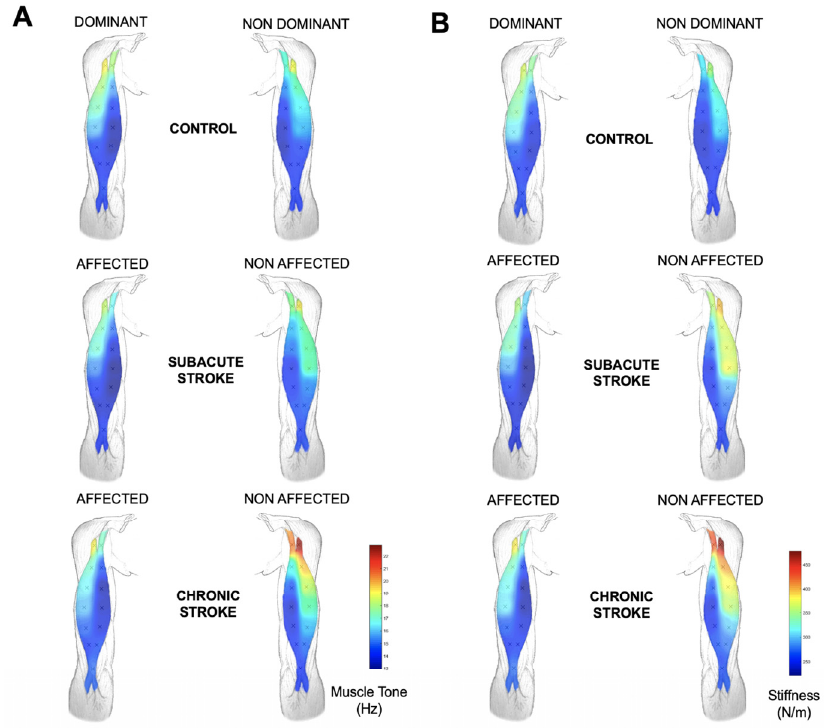
Figure 3. Muscle tone (Hz; A ) and stiffness (N/m; B ) maps based on average values of the assessed locations from the biceps brachii muscle in individuals with subacute and chronic stroke, and control participants.